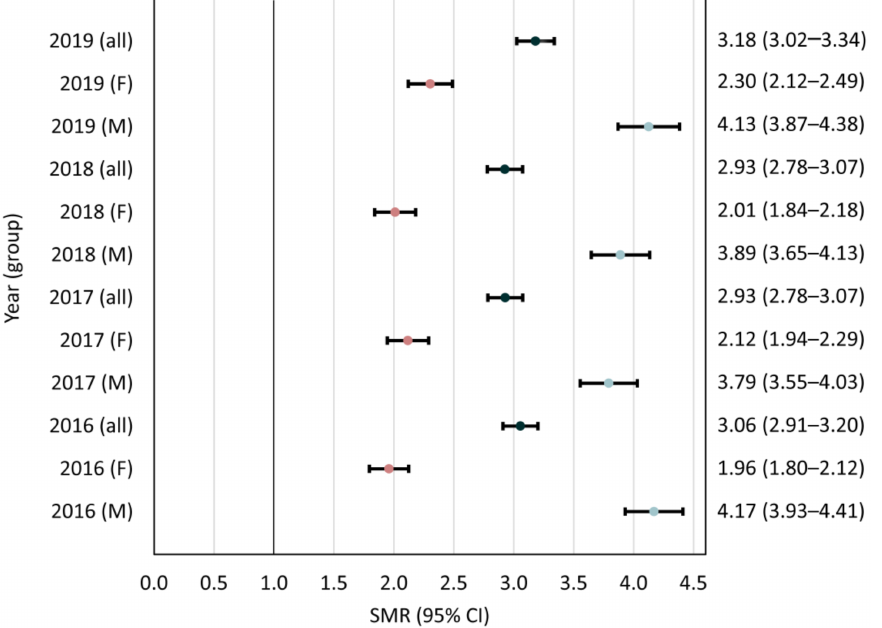
Figure 2. Standardized mortality ratios (SMRs) and 95% confidence intervals (CIs) each year. F— female,